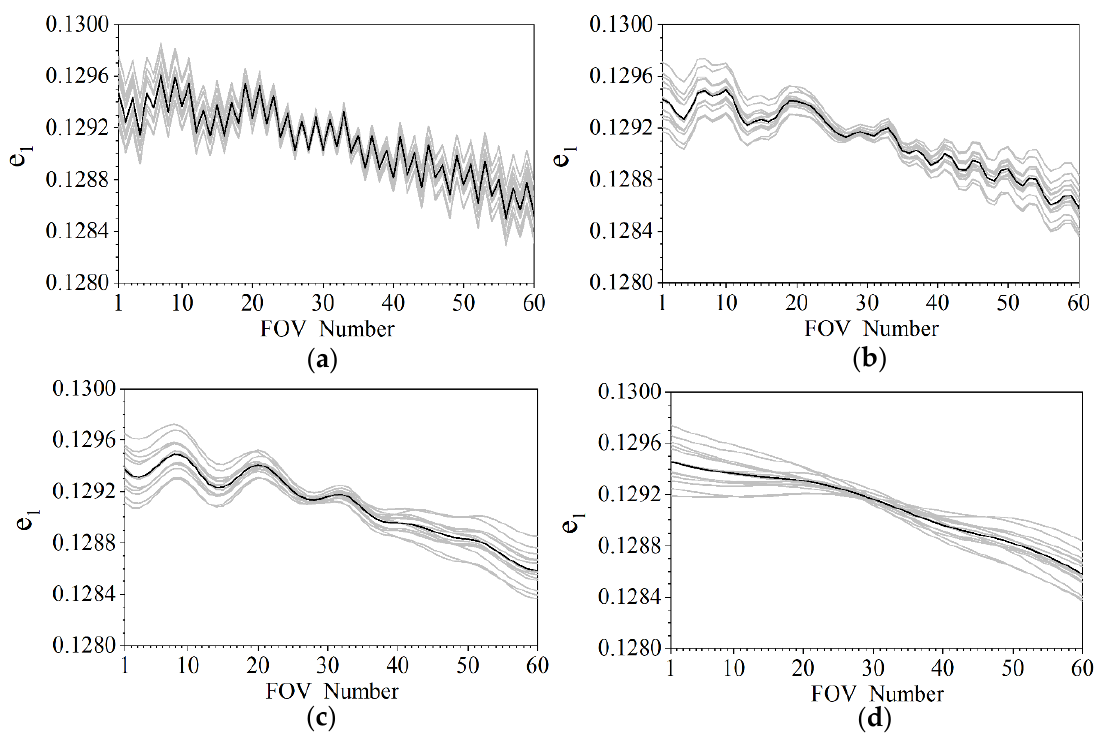
Figure 9. ( a ) The first eigenvector → e 1 of TB observations at channel 4 over the 14 swaths (gray curves) on 7 August 2019 after already removing the along-track high-frequency noise (see examples in the fourth panel in Figure 5). ( b ) Same as ( a ) except for having removed the highest-frequency across-track noise (i.e., the first IMF). ( c ) Same as ( a ) except for having removed the first two high-frequency across-track noises (i.e., the first and second IMFs). ( d ) Same as ( a ) except for having removed the first three high-frequency across-track noises (i.e., the first, second, and third IMFs). Black curve is the mean of the 14 grey curves.